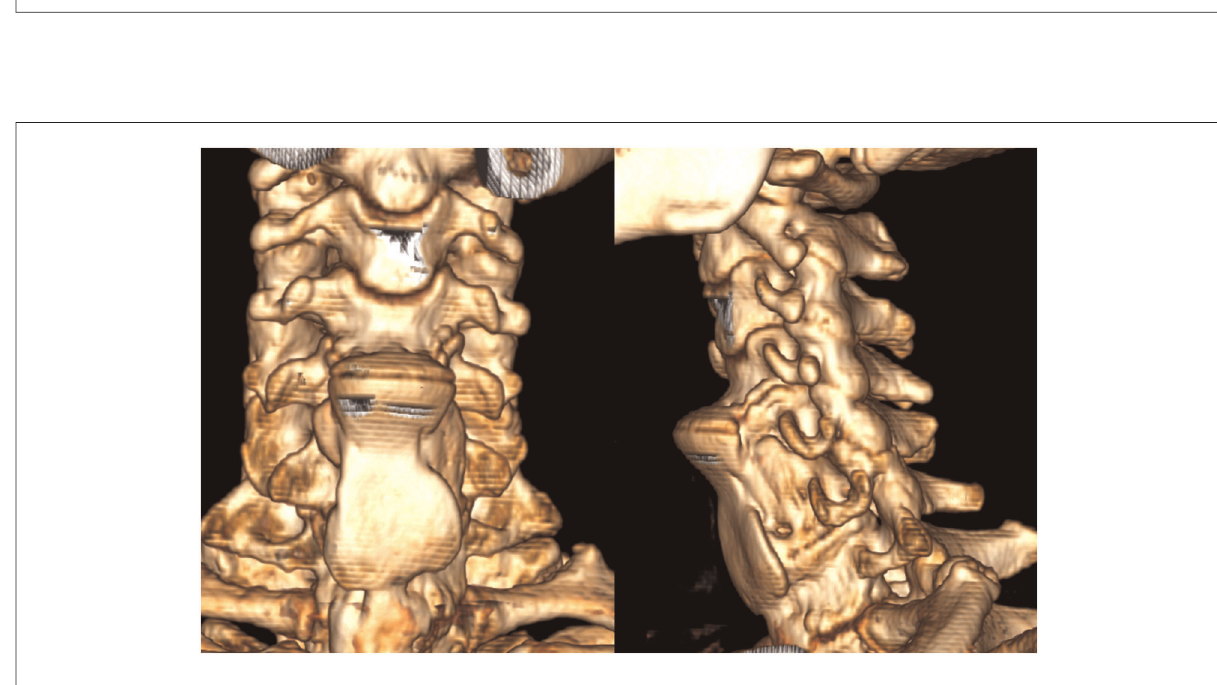
FIGURE 3 The shape of the osteophyte can be clearly seen with 3D reconstructions of cervical vertebrae with CT without soft tissue